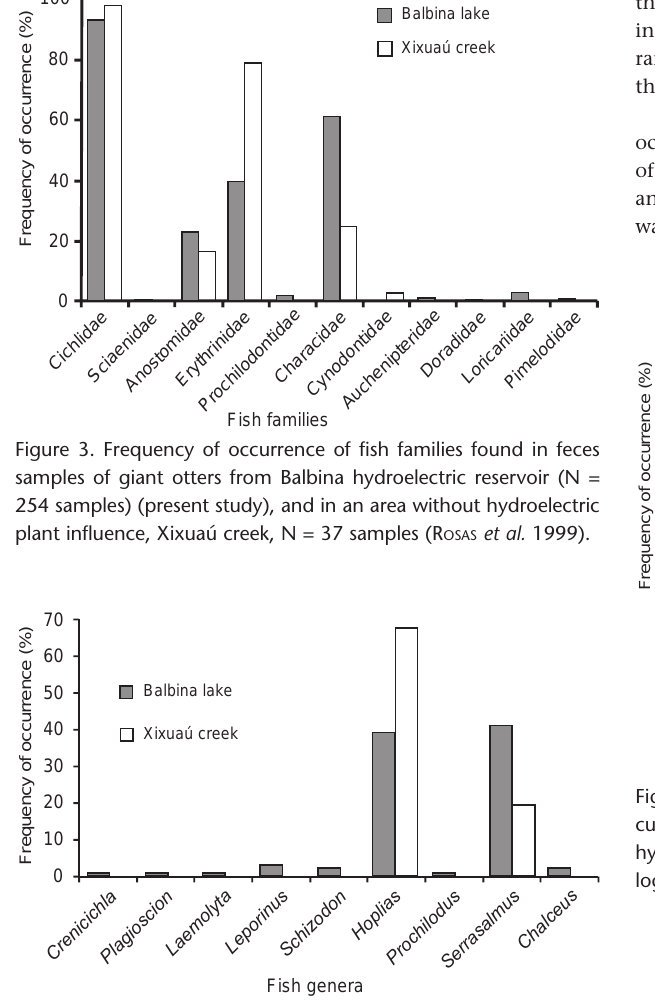
Figure 4. Comparison of the frequency of occurrence of fish gen- era found in feces samples of giant otters from Balbina hydroelec- tric reservoir (N = 254 samples) (present study), and in an area without hydroelectric plant influence, Xixuaú creek, N = 37 samples (R OSAS et al.